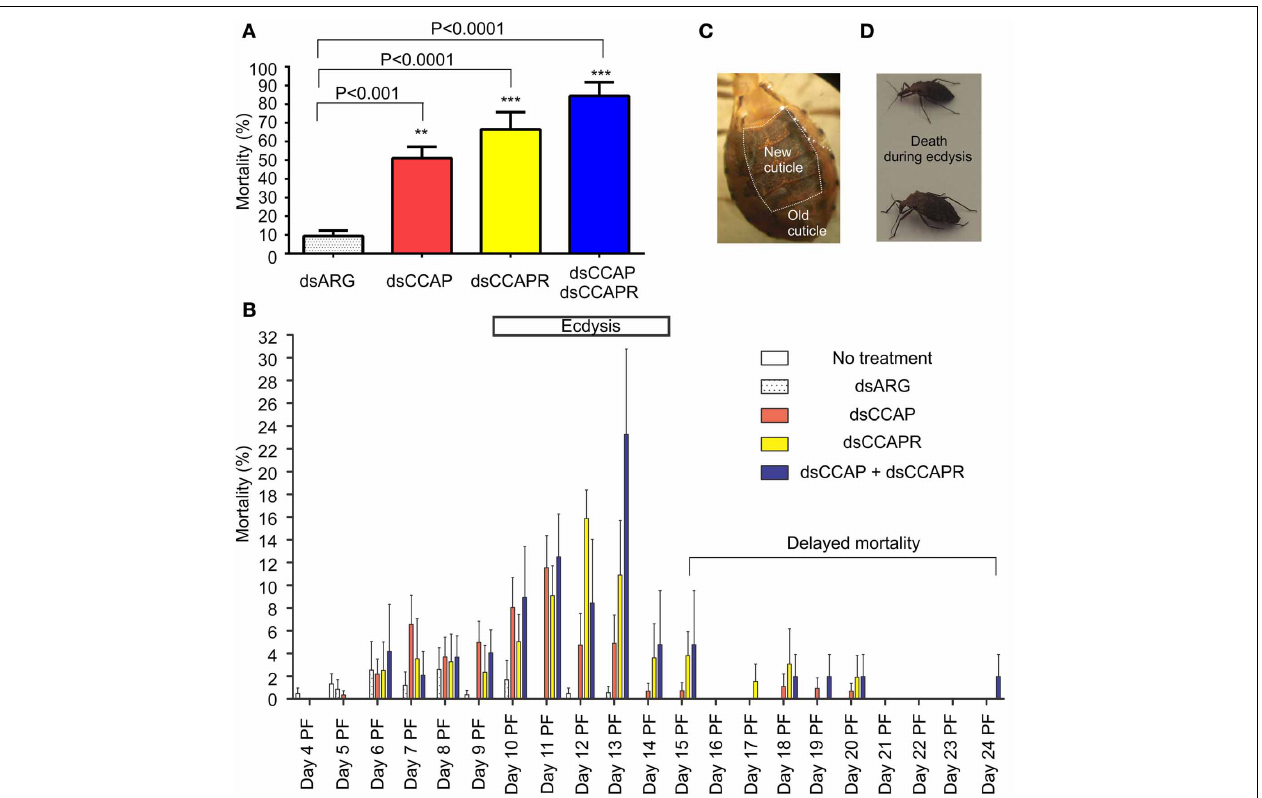
FIGURE 6 | Mortality increases in insects injected with dsRNA of RhoprCCAP, RhoprCCAPR or both in 4th instar R. prolixus . Two micrograms of dsRNA for the ampicillin resistance gene (dsARG), the RhoprCCAP (dsCCAP), RhoprCCAPR (dsCCAPR), or both (dsCCAP and dsCCAPR) were injected into 4th instar R. prolixus on Day 4 post-fed (PF). (A) Insects injected with dsCCAP, dsCCAPR or dsCCAP and dsCCAPR have high mortality rate. Asterisks indicate significant differences compared to the control group that was injected with